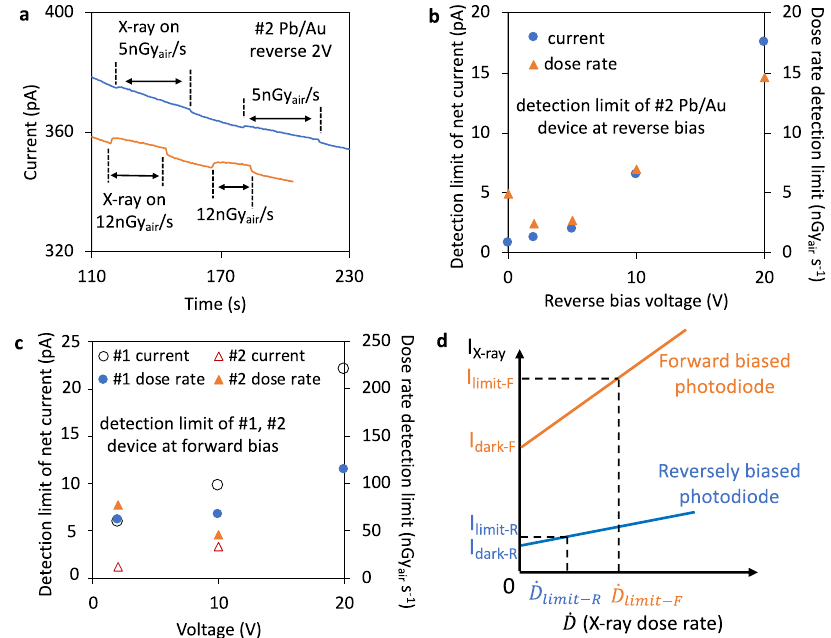
Fig. 4 Detection limit obtained by the dark current method for MAPbI 3 detectors working in different mode. a Experimentally measured current response of reversely biased #2 Pb/Au photodiode to X-ray dose rates approaching the detection limit. Calculated detection limit of net current I limit and X-ray dose rate detection limit _ D limit for the b reversely biased #2 Pb / Au photodiode, and for the c #1 Au/Au photoconductor and forward biased #2 Pb/ Au photodiode. d qualitative comparison of sensitivity (slope of the linear fi tting) and dark current for photodiode under forward vs reverse bias mode. The subscripted F and R stands for forward and reverse bias mode, respectively.